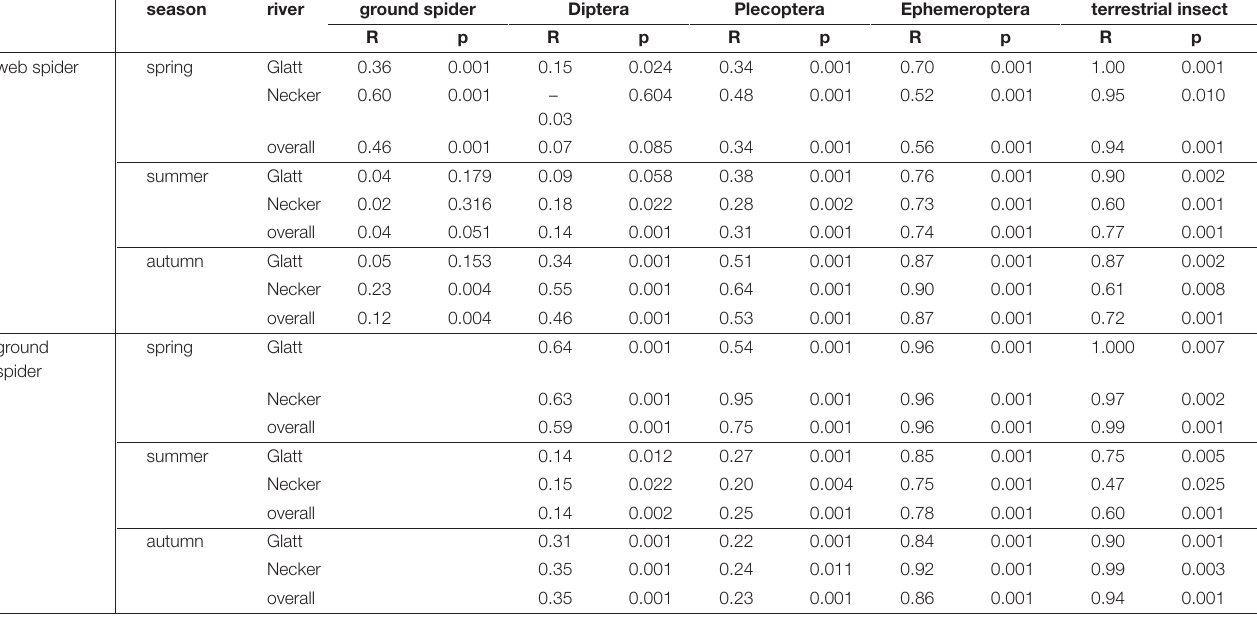
TABLE 3 | Pairwise Similarity (ANOSIM) of PUFA profiles of prey and predator groups at each of the systems (Necker, Glatt) and overall (both rivers). season river ground spider Diptera Plecoptera Ephemeroptera terrestrial insect